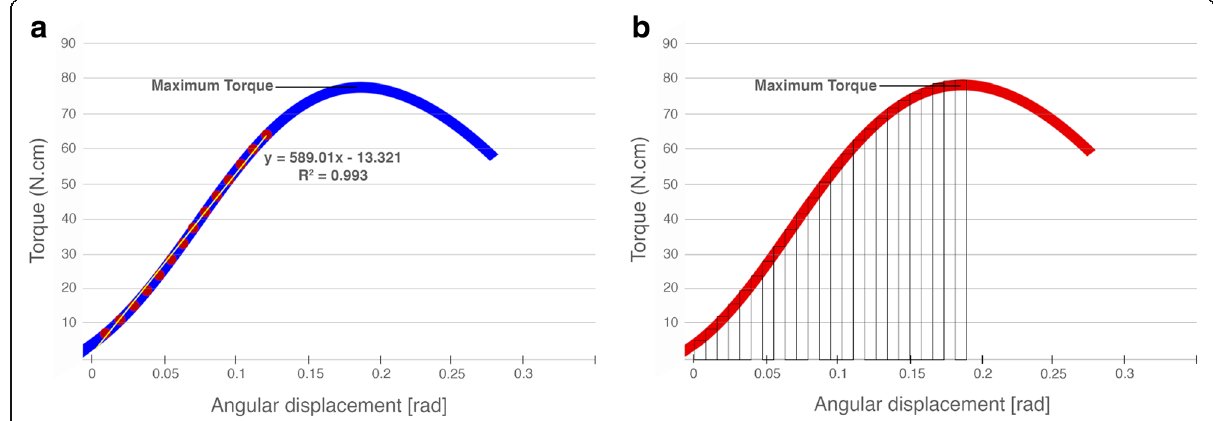
Fig. 3 Representative curve of the torque test for implants. a Graph of torque versus angular displacement with linear regression curve, and equation, representing the connection stiffness. b Determination procedure of unscrewing implant work up to test ’ s maximum torque